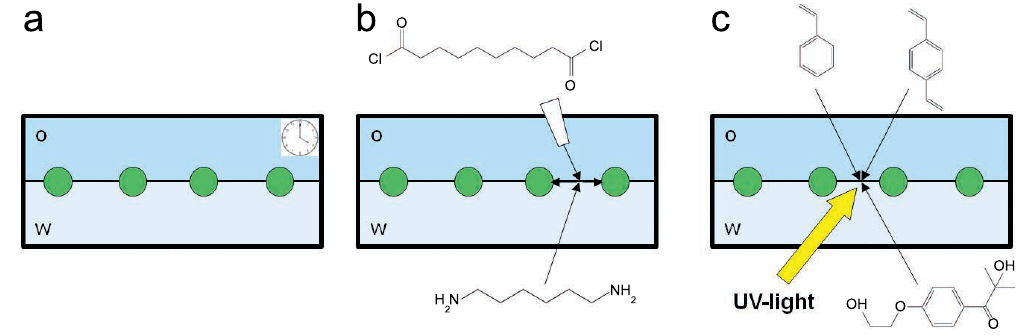
Figure 1. Schematics of the three different immobilization routes. ( a ) spontaneous immobilization at a water–decane interface. Particles within the monolayer simply become immobile with time; ( b ) nylon interfacial polymerization. After the spontaneous interfacial adsorption of 1,6-diaminohexane from the water phase, sebacoyl dichloride is injected into the organic phase to start the polymerization; ( c ) polystyrene interfacial polymerization. After the spontaneous interfacial adsorption of the monomer (styrene) and crosslinker ( p -divinylbenzene) from the oil phase and of the initiator (Irgacure 2959) from the water phase, the system is illuminated by UV light to initiate the free radical polymerization of styrene at the